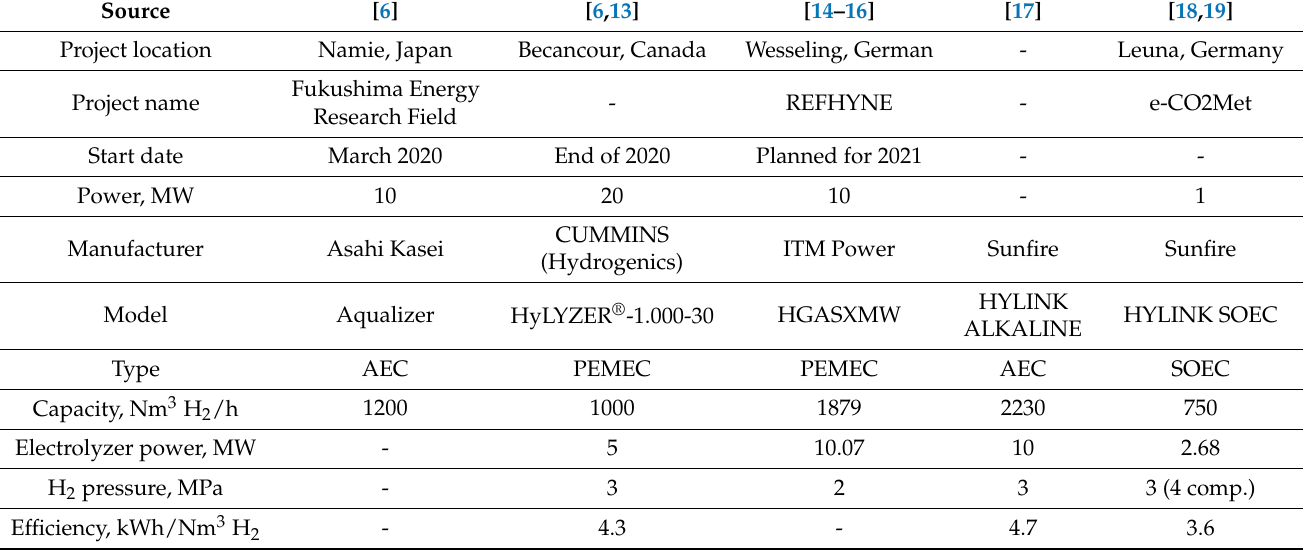
Table 2. Characteristics of megawatt-class electrolysis